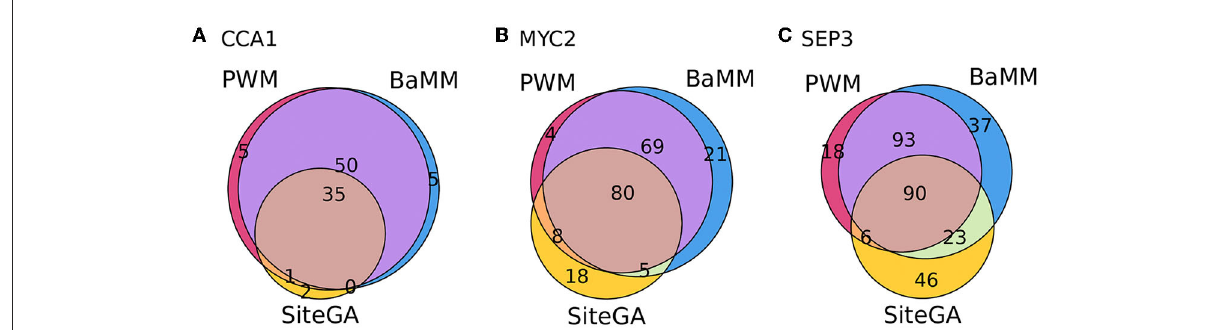
FIGURE8 Venn diagrams for overlaps between the number of genes containing the sites predicted by PWM, BaMM, and SiteGA motif models and supported by the significantly enriched GO terms. (A–C) Show CCA1, MYC2, and SEP3 datasets. For each dataset, we included in the analysis the same set of the GO terms; each GO term possessed the significance of enrichment ( p _adj < 0.05) for three motif models